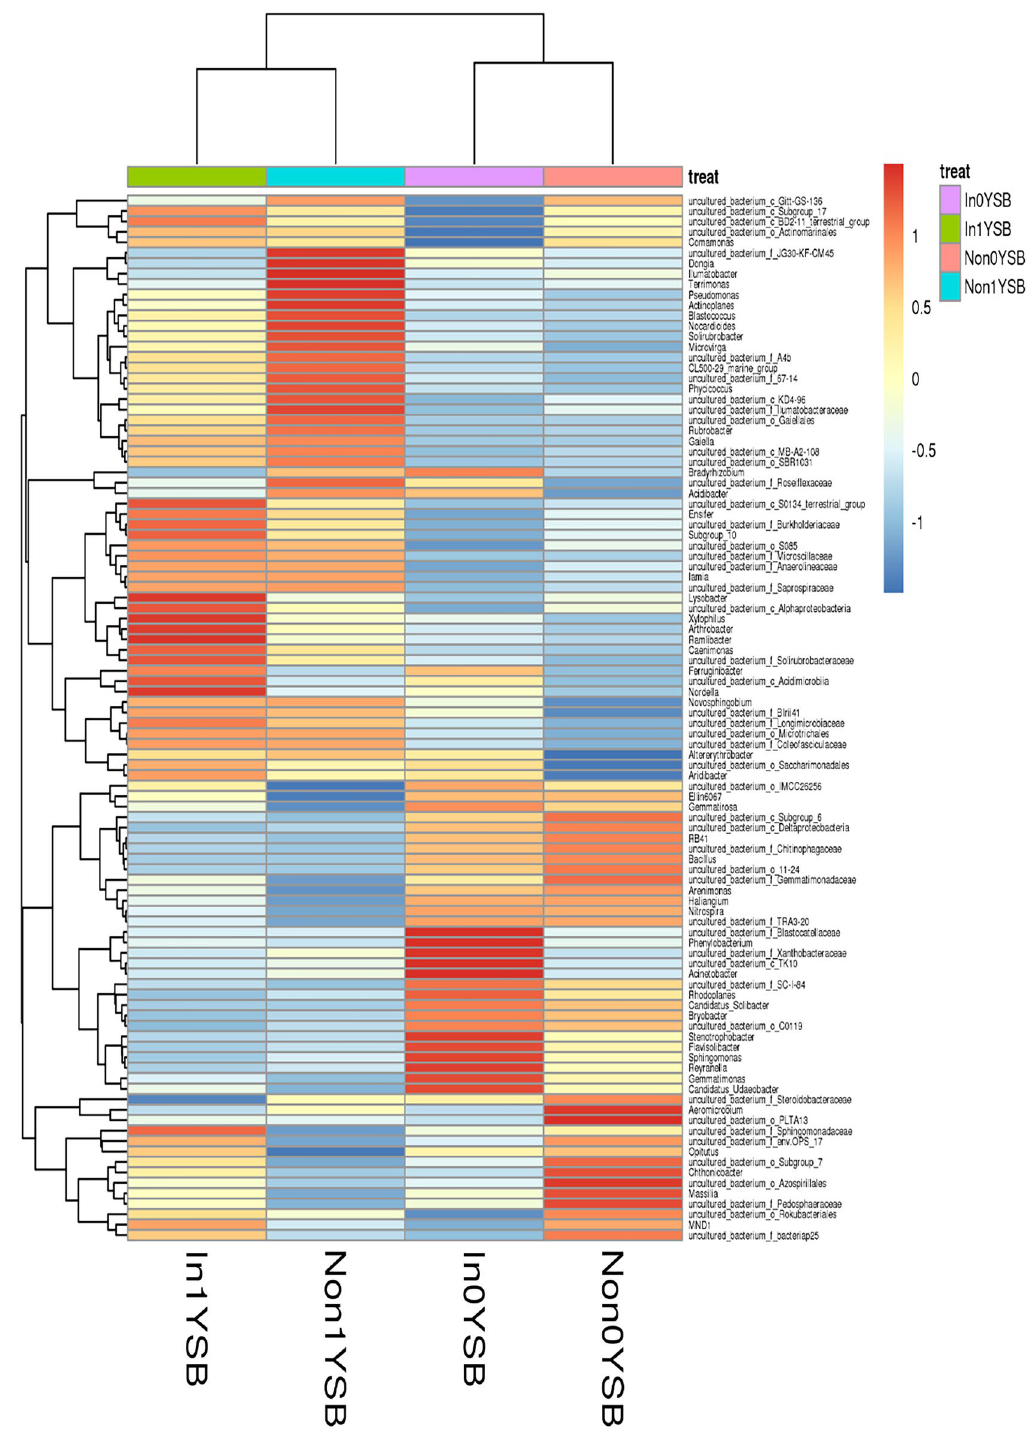
Figure 4. Heat map of the 100 most abundant bacterial genera. Non represents non-inoculated with R. intraradices . In represents inoculated with R. intraradices . 0Y and 1Y represent 0 year and 1 year of continuous cropping, respectively. SB represents bacteria in rhizosphere